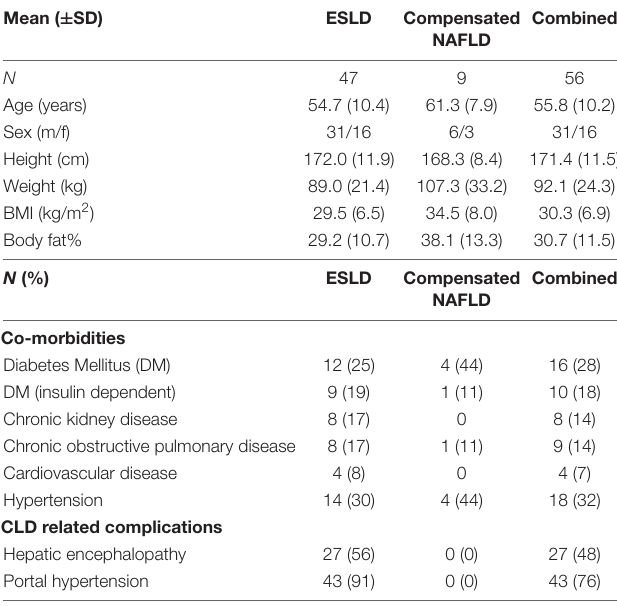
TABLE 1 | Patient characteristics, co-morbidities, and CLD related complications for both ESLD and non-cirrhotic NAFLD groups, as well as combined.